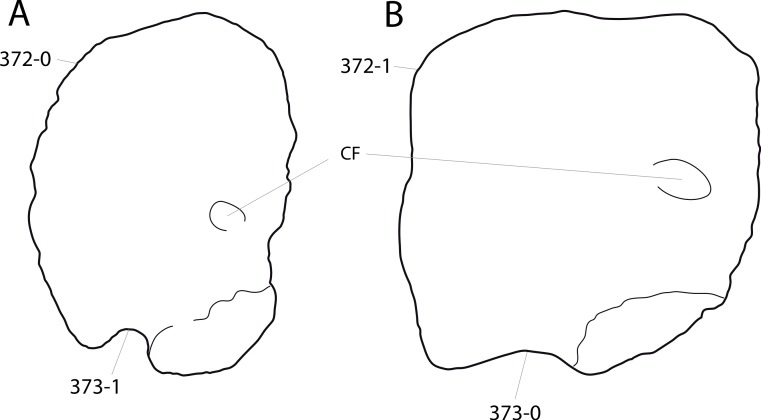
Neosauropod coracoids.Left coracoids of Amphicoelias altus AMNH 5764? (A) and Apatosaurus ajax YPM 1860 (B; traced from Bakker, 1998) in anterolateral view. Note the rounded (A; C372-0) instead of rectangular shape (B; C372-1), and the deep (A; C373-1) in contrast to shallow infraglenoid groove (B; C373-0). Abb.: CF, coracoid foramen. Scaled to the same height.